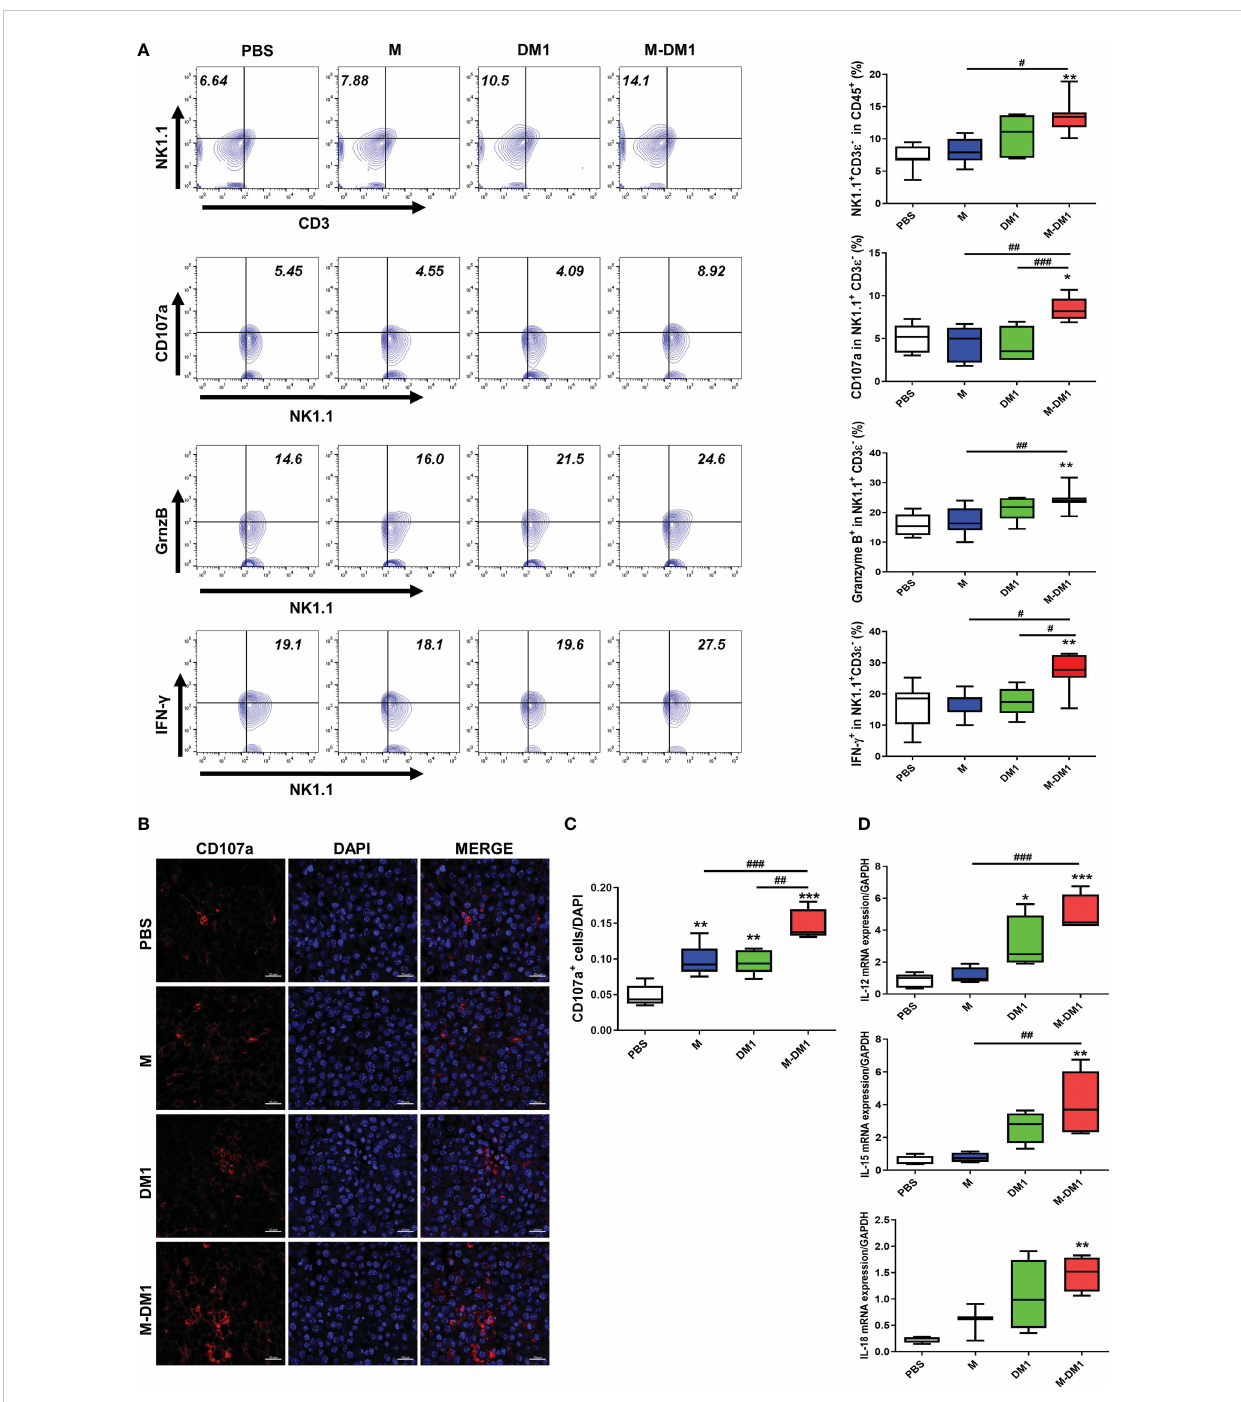
FIGURE 8 M-DM1 regulates the activation of in fi ltrated NK cells by regulating the secretion of related cytokines. (A) Expression of NK 1.1, CD107a, Granzyme B, and IFN- g in CD45- positive cells upon treatment with M, DM1, and M-DM1. Representative contours are shown ( n = 7 ). (B, C) The expression of CD107a as a marker of NK cell functional activity was evaluated through immuno fl uorescence staining (scale bar = 20 m m). (D) Cytokines, such as IL-12, IL-15, and IL-18, related to NK cell survival and proliferation, were examined by real-time PCR ( n = 5). All data are presented as the mean ± SD. One-way ANOVA followed by Tukey ’ s post-hoc test was performed for group comparisons; *p < 0.05, **p < 0.01, ***p < 0.001 vs PBS group; #p < 0.05, ##p < 0.01, ###p < 0.001 vs M or DM1